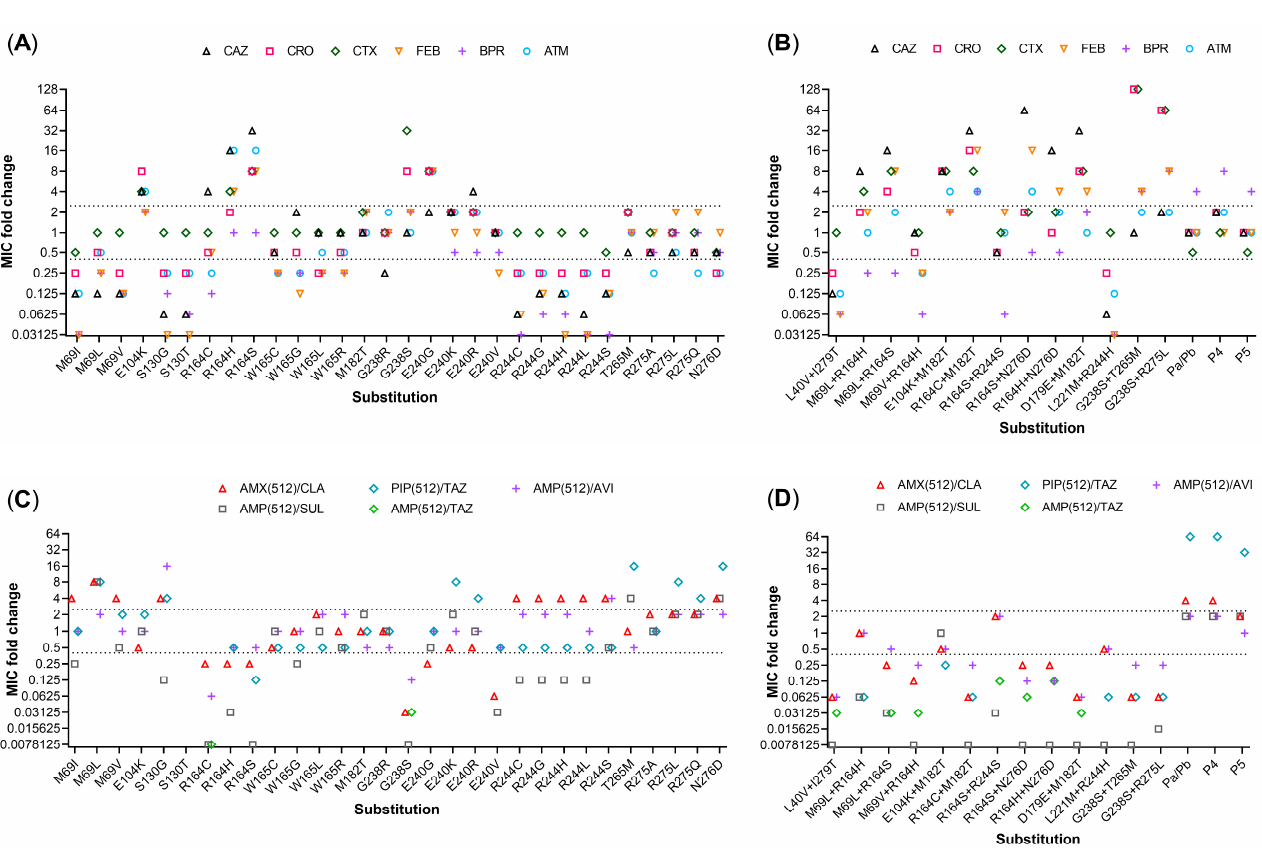
Figure 3. Changes in MIC of single mutants ( A , C ) and double mutants ( B , D ) compared to the parenteral strains (SM-1, or SM-2 for promotor mutants) against ( A , B ) cephalosporins and aztreonam, or for ( C , D ) penicillin/BLI combinations. Mutant S130T that was sensitive to all tested penicillins, therefore the penicillin/inhibitor combinations could not be determined. Some mutants were sensitive for PIP, therefore TAZ was combined with AMP.